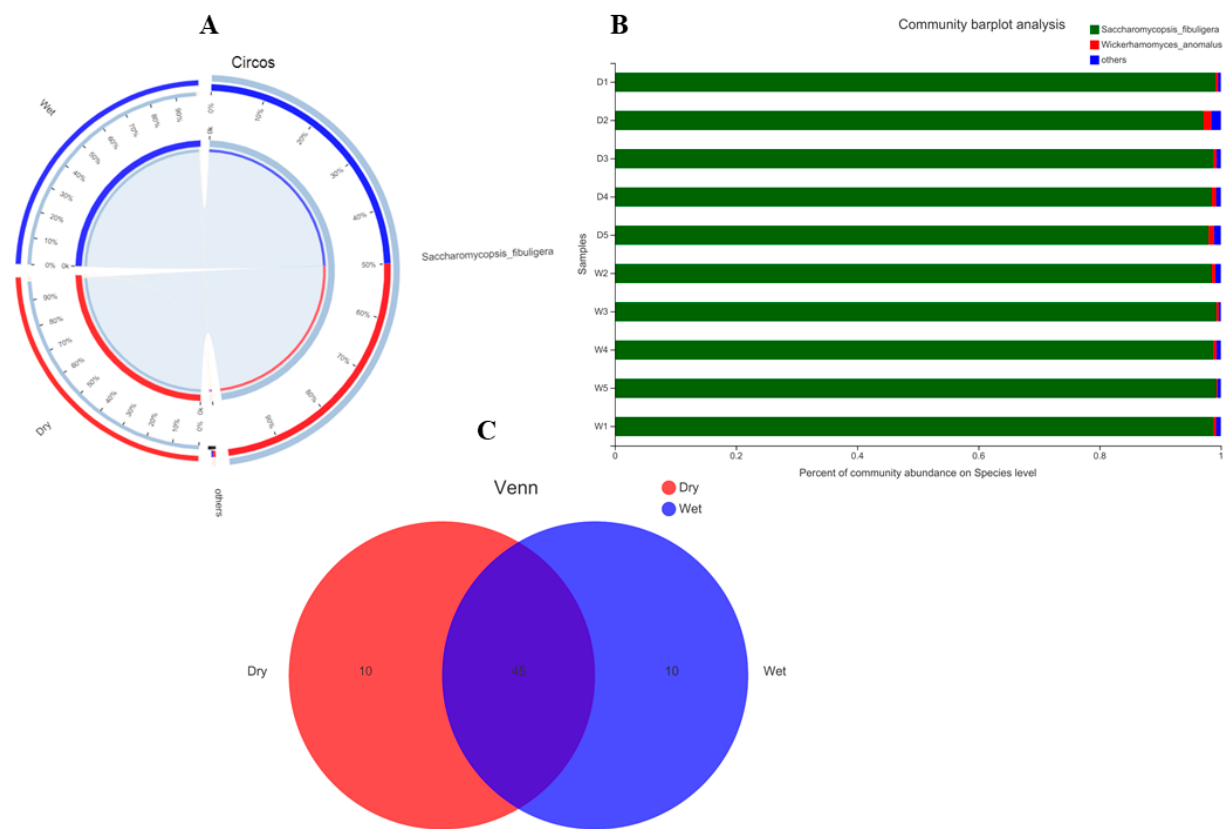
Figure 2. ( A ) (Fungi) In the Circos sample and species relationship diagram, the small semicircle (left half circle) represents the composition of species in the sample, the color of the outer ribbon represents which group it comes from, the color of the inner ribbon represents the species, and the length represents the species’ relative abundance in the corresponding sample; the large semicircle (right half circle) represents the distribution ratio of species in different samples at the taxonomic level, the outer ribbon represents species, the inner ribbon color represents different groups, and the length represents the species’ proportion of distribution in a sample. ( B ) The abscissa/ordinate is the sample name, the ordinate/abscissa is the proportion of species in the sample, the columns of different colors represent different species, and the column length represents the proportion of the species. ( C ) (Fungi). The graph shows a Venn diagram, different colors represent different groups (or samples), the numbers in the overlapping parts represent the number of species shared by multiple groups, and the numbers in the non-overlapping parts represent the number of species unique to the corresponding group if the group is greater than or equal to 6.